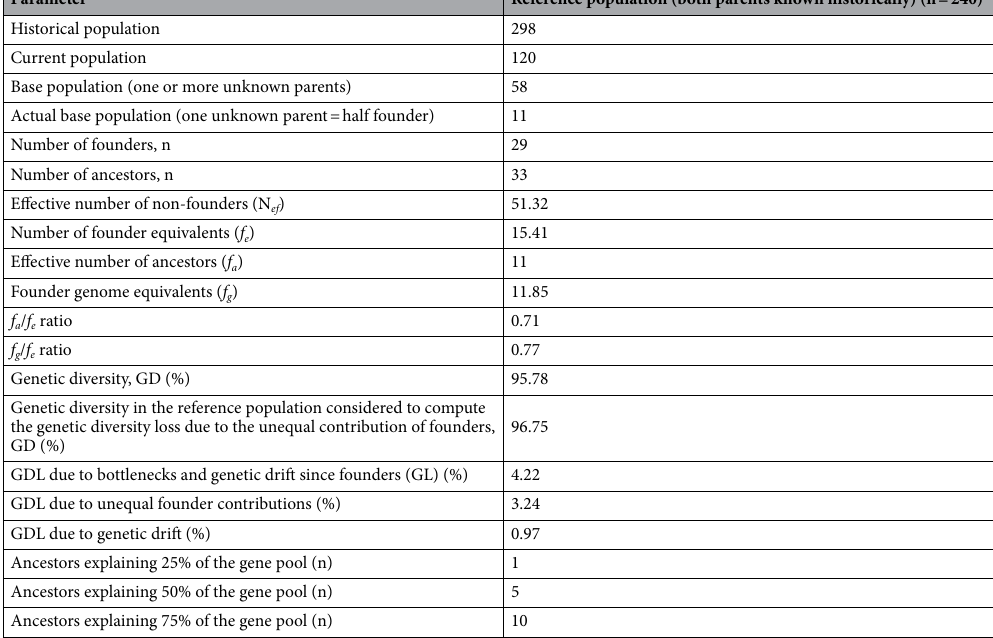
Table 4. Summary of results for founder analysis, measures of genetic diversity and diversity loss. GDL Genetic diversity loss.